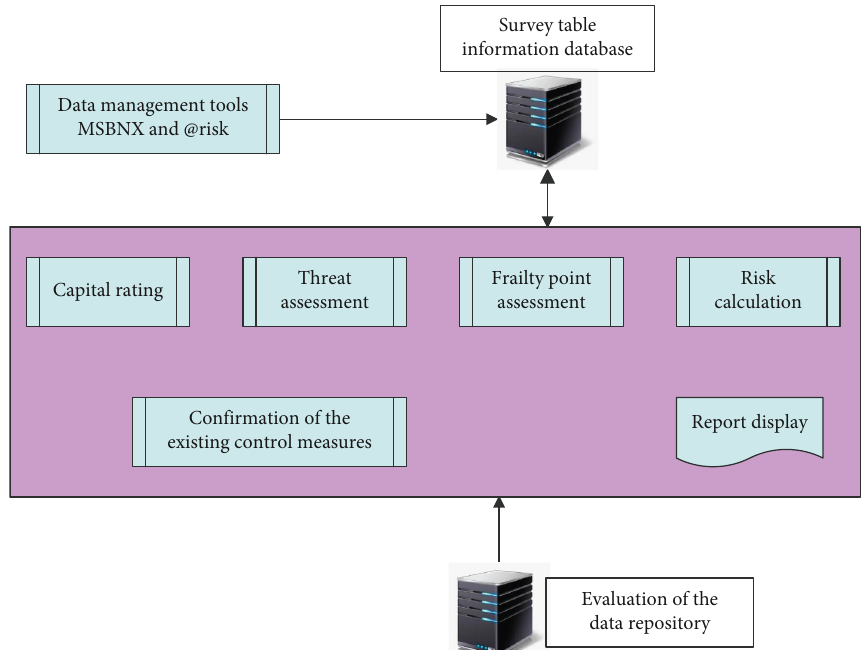
Figure 7: Software overall architecture design based on Rasch model.